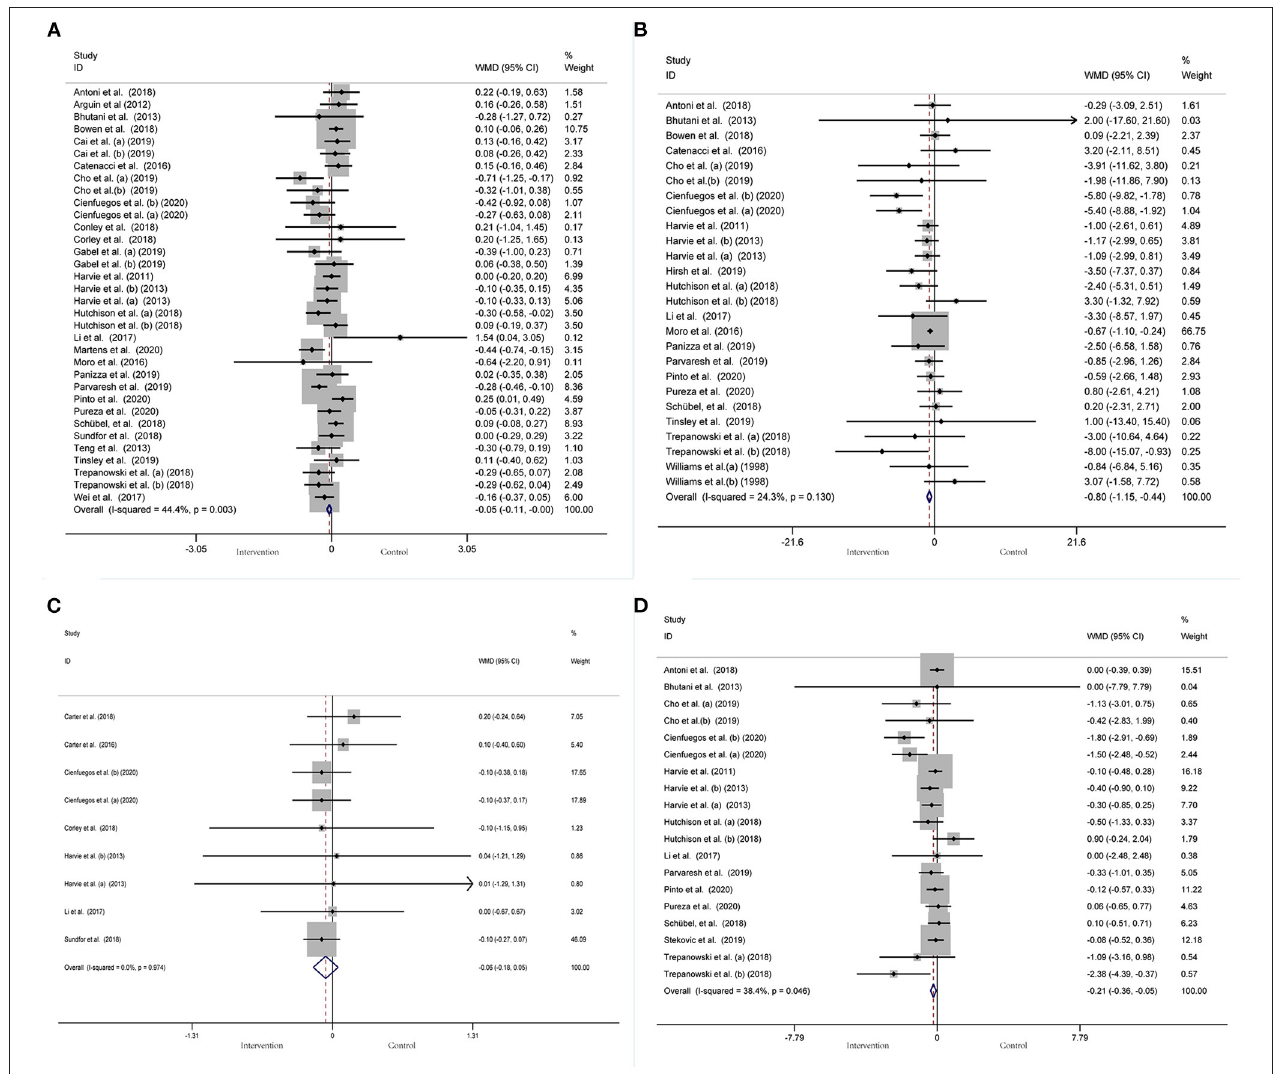
FIGURE 5 | Forest plot of RCTs investigating the effects of intermittent fasting on glycemic control (A) FBG, (B) Fins, (C) HbA1c, (D)